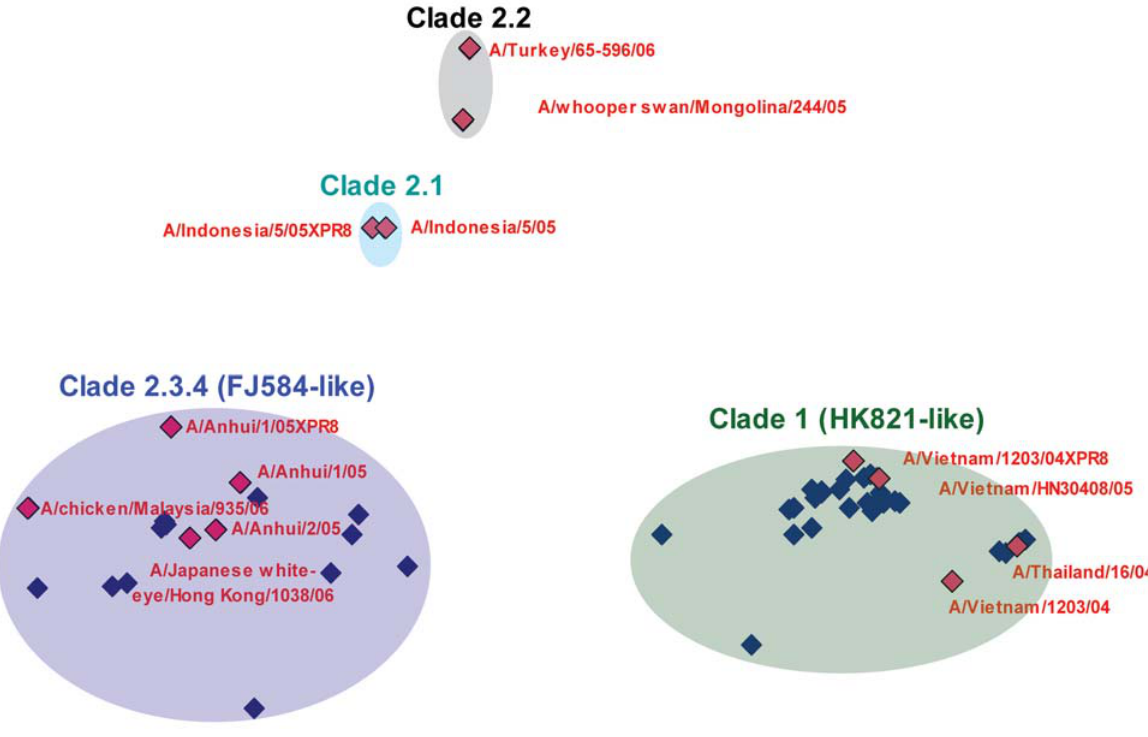
Figure 5. Two major antigenic groups circulated in Vietnam during 2007. There are 13 WHO reference antigens (marked in red diamonds) and each of the 40 HPAI H5N1 Vietnam viruses isolated in 2007 (marked in blue diamonds; Table S1). Multidimensional scaling analysis was used to characterize the antigenicity of these viruses based on HI data using SPSS 15.0 (SPSS, Inc.) with the default s-stress convergence value of 0.001.